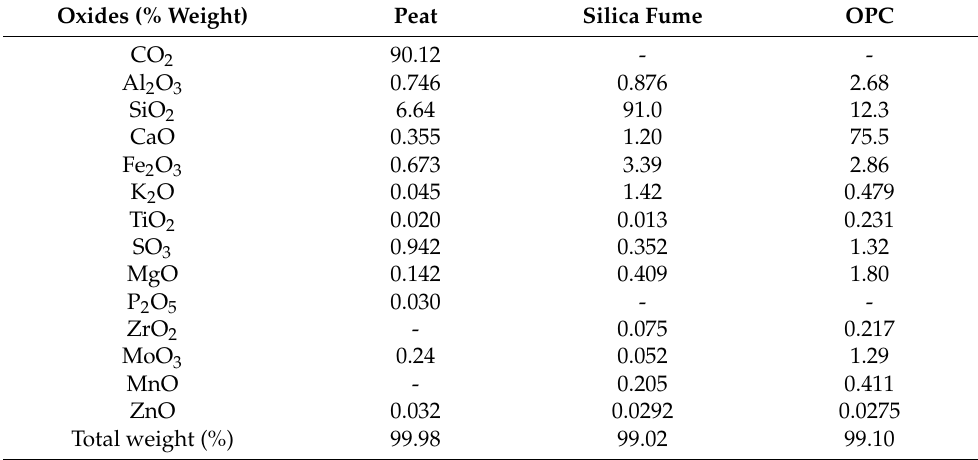
Table 1. Chemical compositions (weight percentages) of peat, SF, and OPC revealed by XRF analysis.